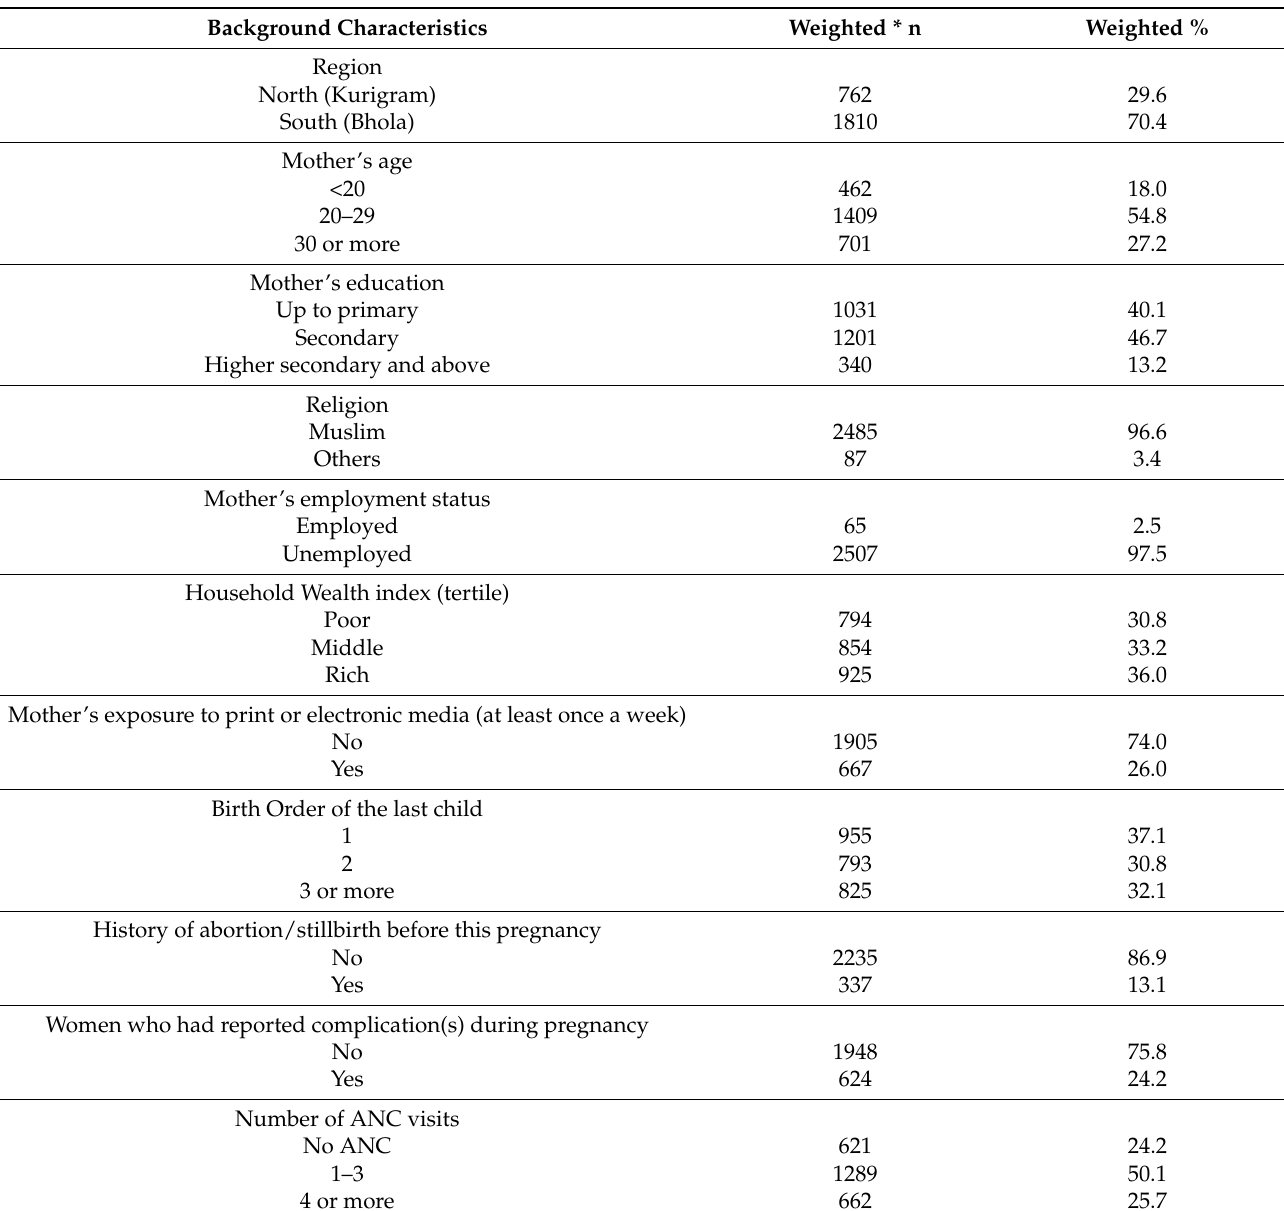
Table 1. Socio-demographic and obstetric characteristics and antenatal care-seeking practices among 2572 women who had a live birth in the six months preceding the